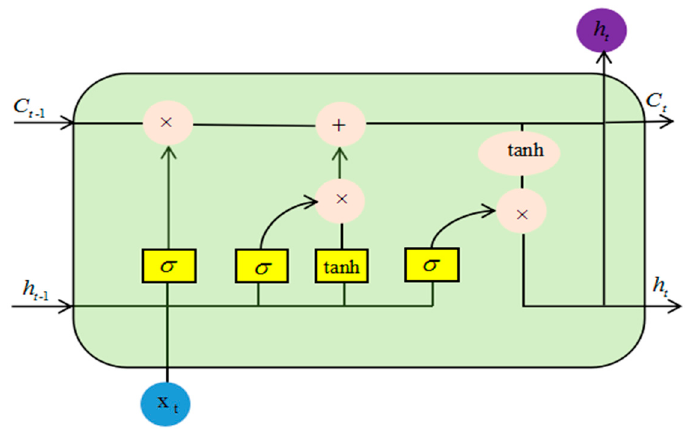
Figure 13. LSTM network structure.